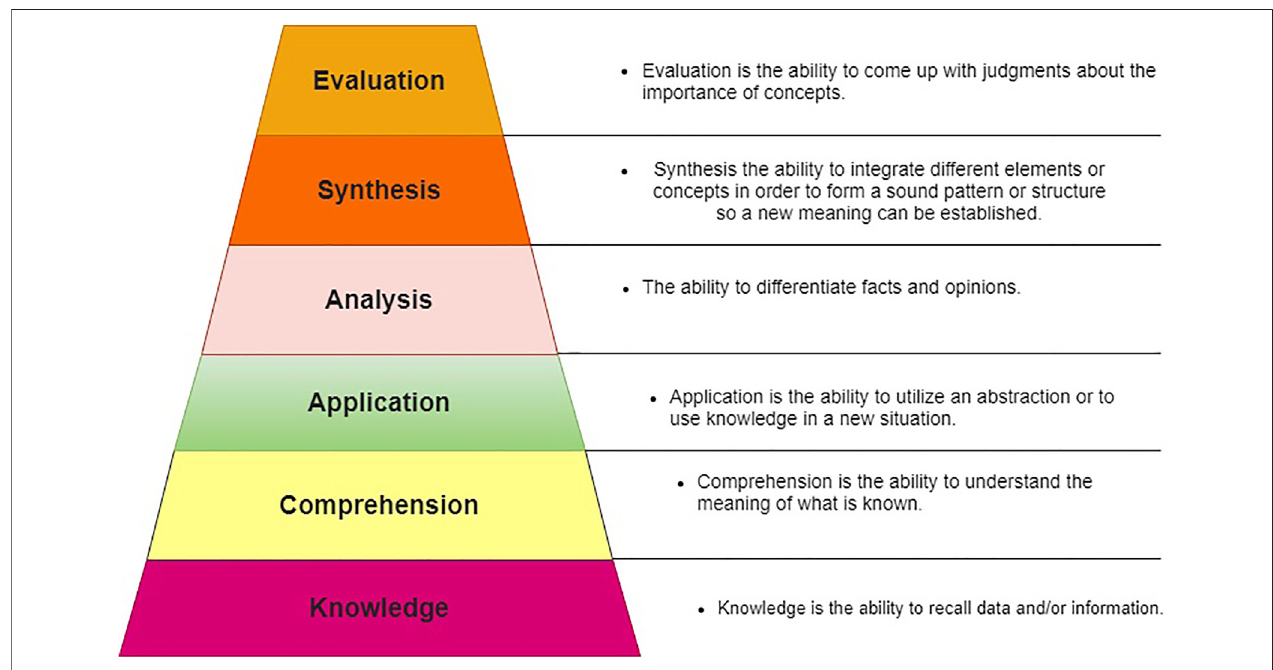
FIGURE 6 | Bloom ’ s Taxonomy with six categories (Anderson and Sosniak, 1994).